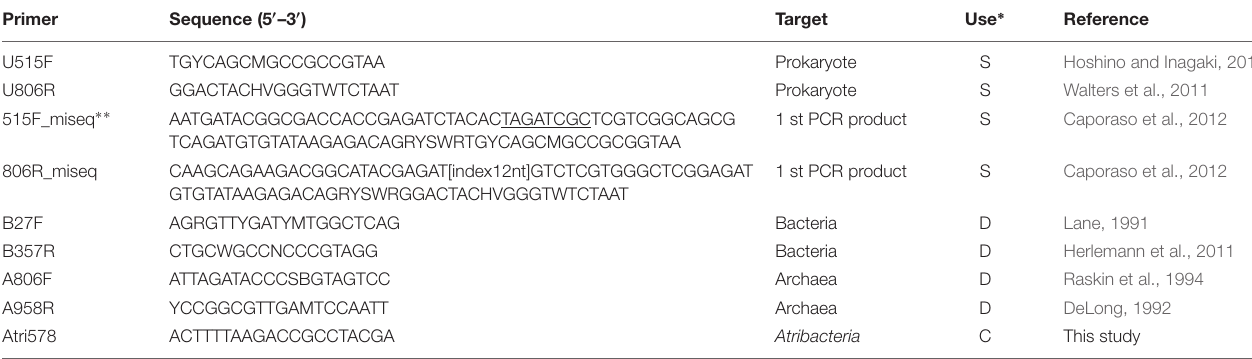
TABLE 2 | Oligonucleotide primers and Atribacteria -specific probe used in this study. Primer Sequence (5 (cid:48) –3 (cid:48)